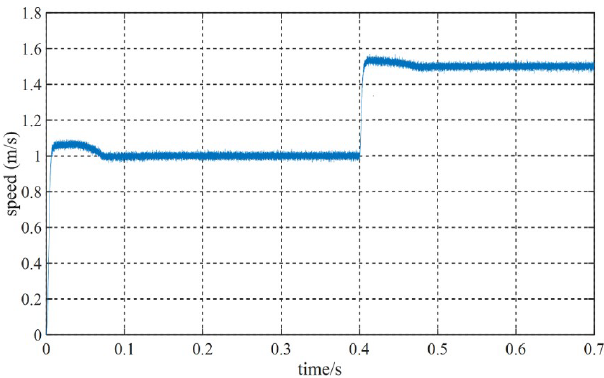
Figure 13. Speed waveform of MFSC controller.